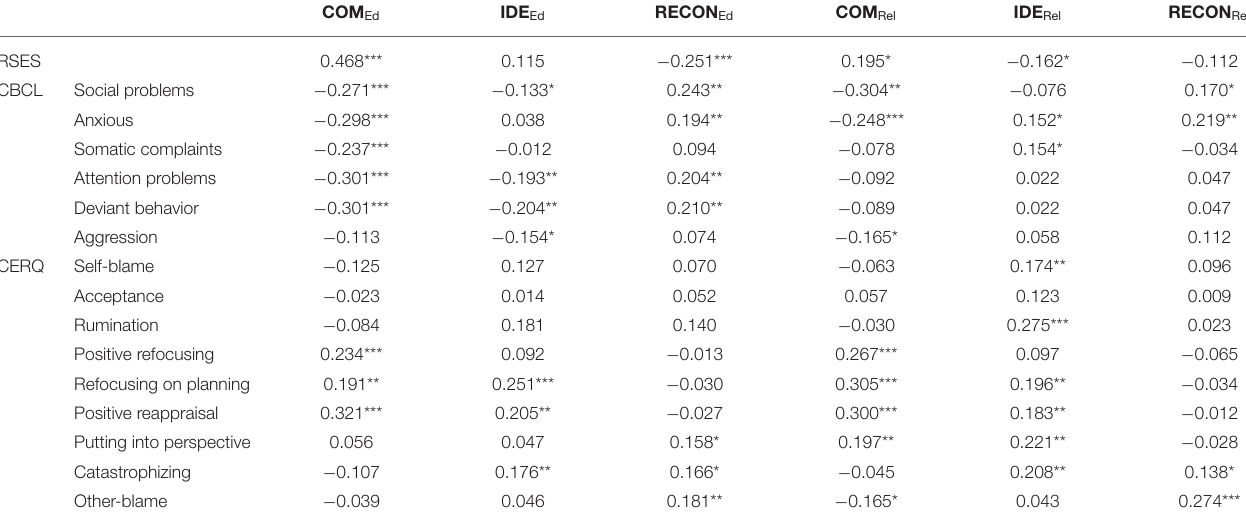
TABLE 6 | Relationship between the six dimensions of H-UMICS (three dimensions each for educational and relational identity) and measured variables; results of Pearson’s